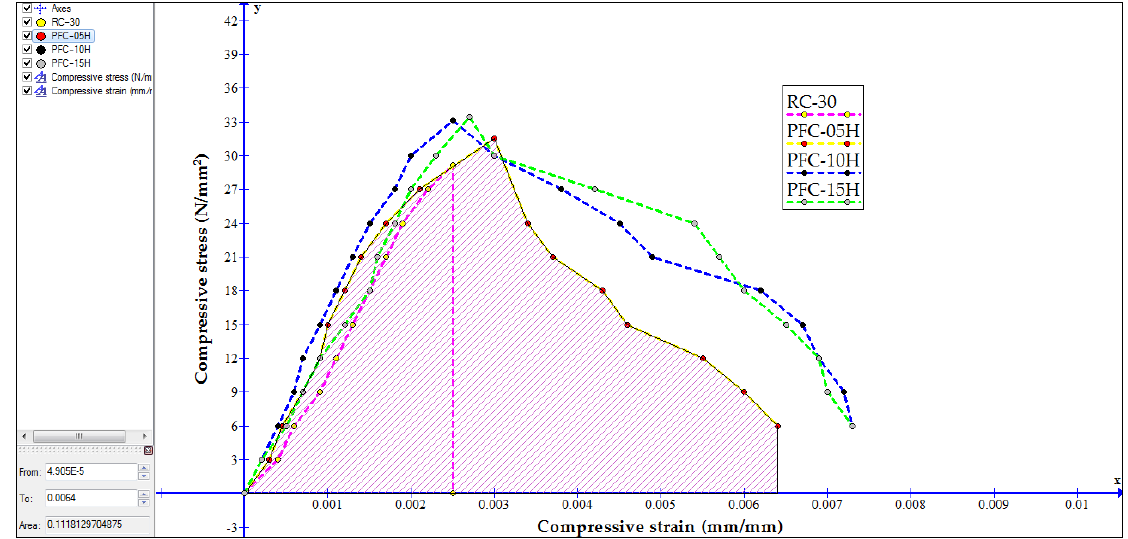
Figure 9. Absolute toughness calculation using a graph (shaded area) for various fiber concretes.